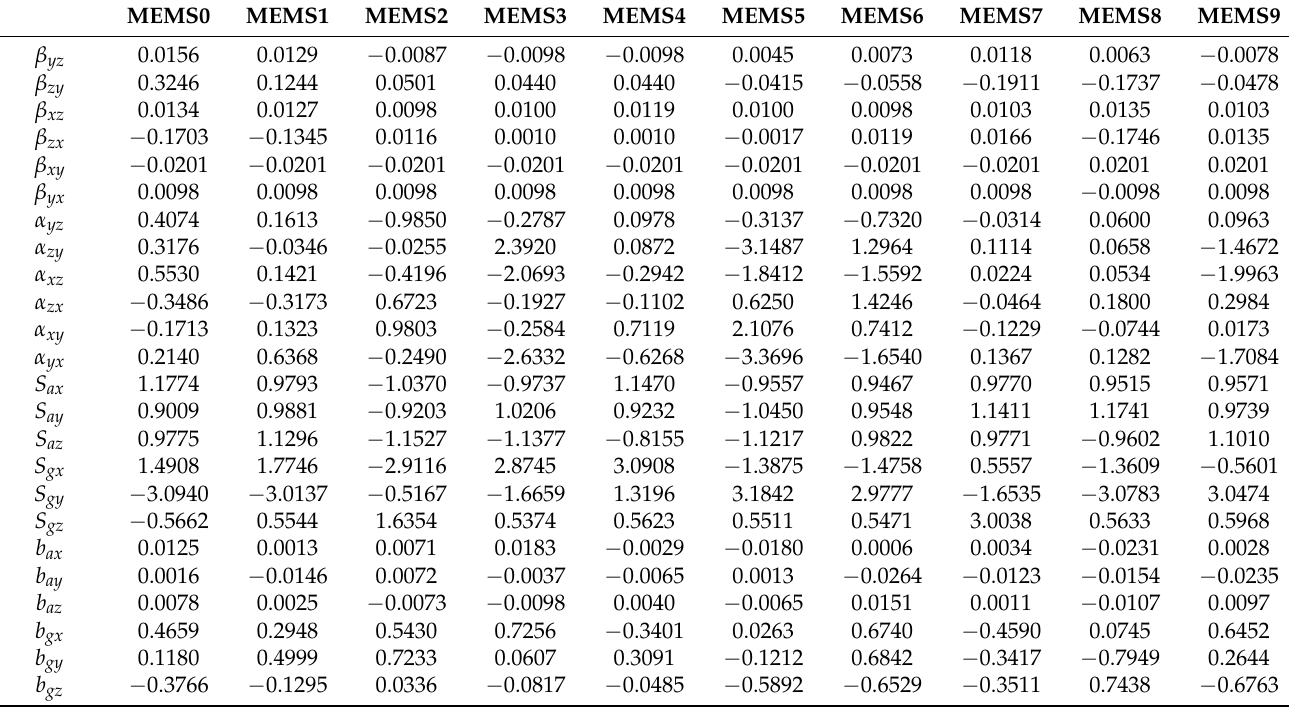
Table 3. Fixed error parameters for accelerometers and gyroscopes.